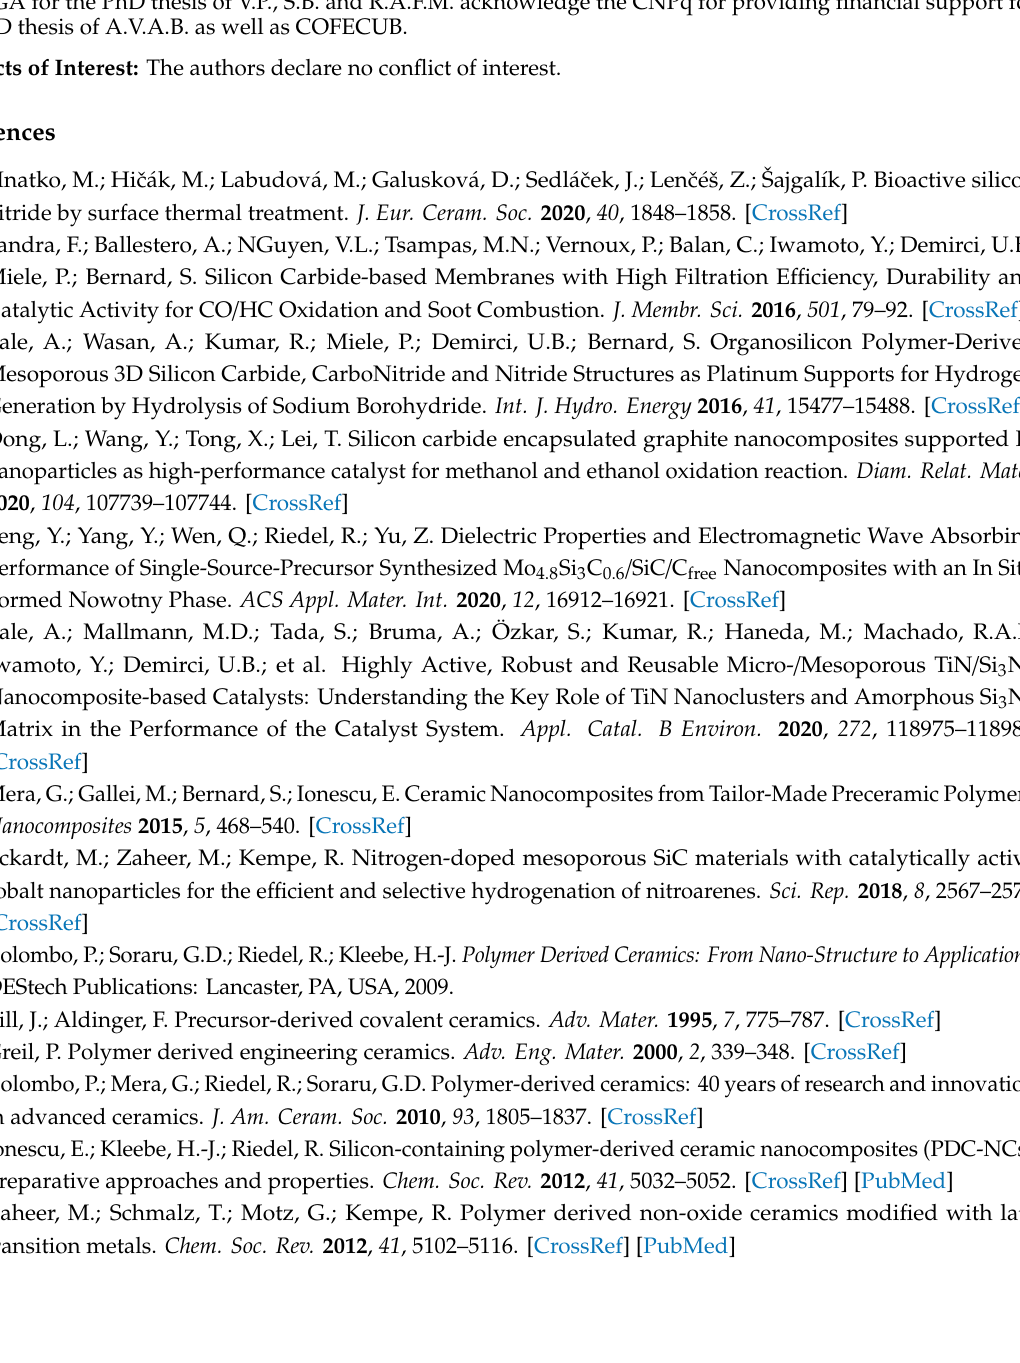
(c) samples with FFT images obtained from HRTEM images of P-1500N (b) and P-1500A (c) samples as insets, Figure S8: EDS mapping of the P-1600A sample, Figure S9: EDS mapping of the P-1800A